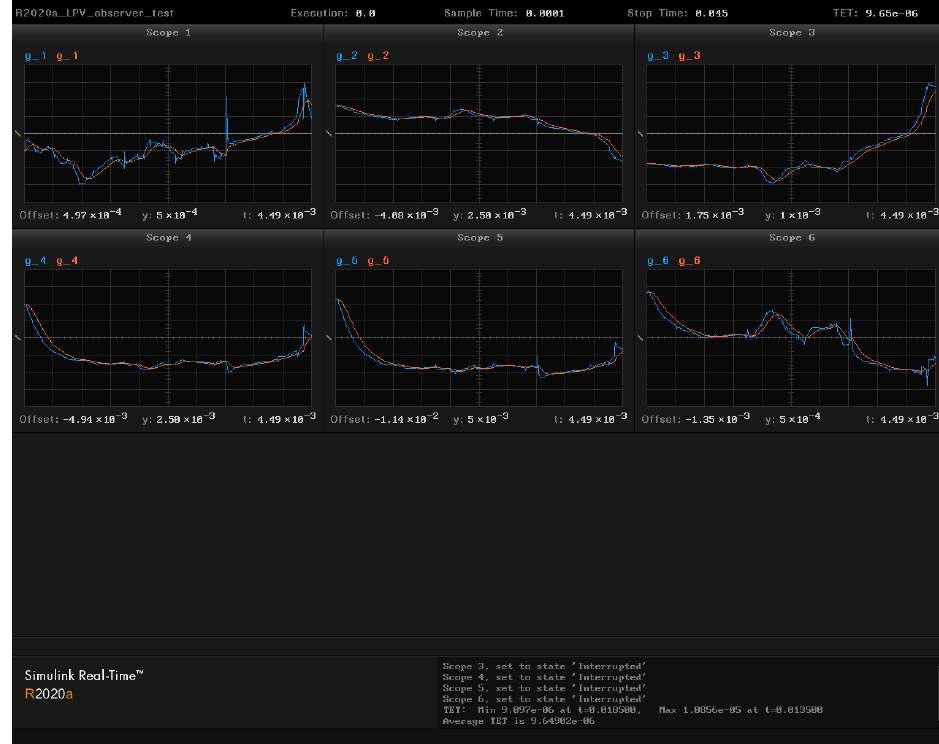
Figure 16. Real-time simulation of gaps variations δ g derived by LPV model obtained from the FCDI code (blue line) and estimation of gap variations δ ˜ g obtained from robust observer synthesized by LMIs (red line). Discharge #37263.